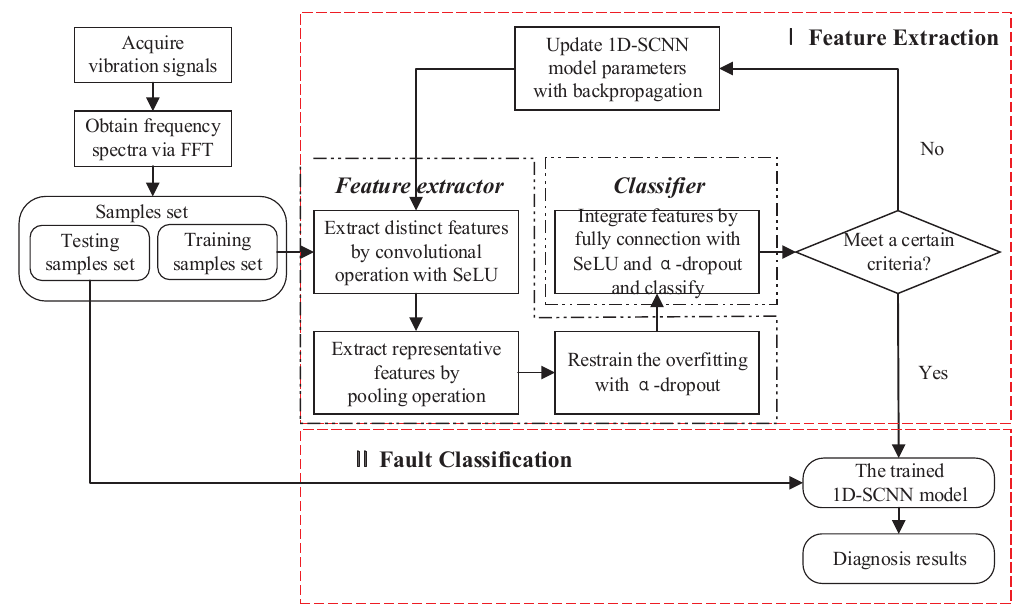
Figure 1. The block diagram of the proposed